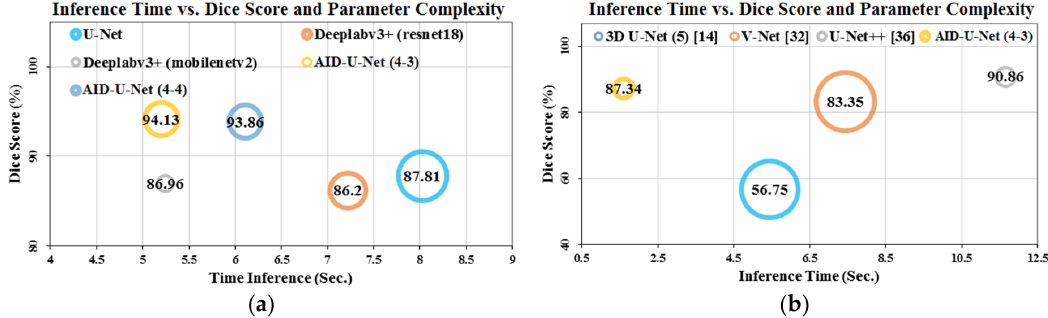
Figure 11. Time inference of several semantic segmentation networks vs. efficiency and different learnable parameters for processing of: ( a ) 2K optical colonoscopy test images belonging to Etis-Larib dataset, and ( b ) 2.4K CT-Scan volumes belonging to BraTS dataset based on the inference time calculations for the competitive methods proposed in [14] as 3D U-Net, [32] as V-Net, [36] as U-Net++ and Aid-U-Net with direct and sub-path combination as